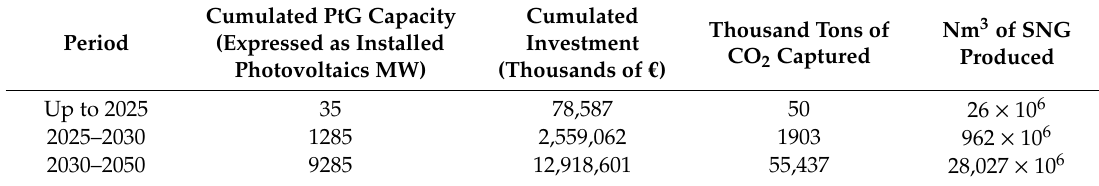
Table 5. Installed capacity, investment, CO 2 captured, and synthetic natural gas (SNG)